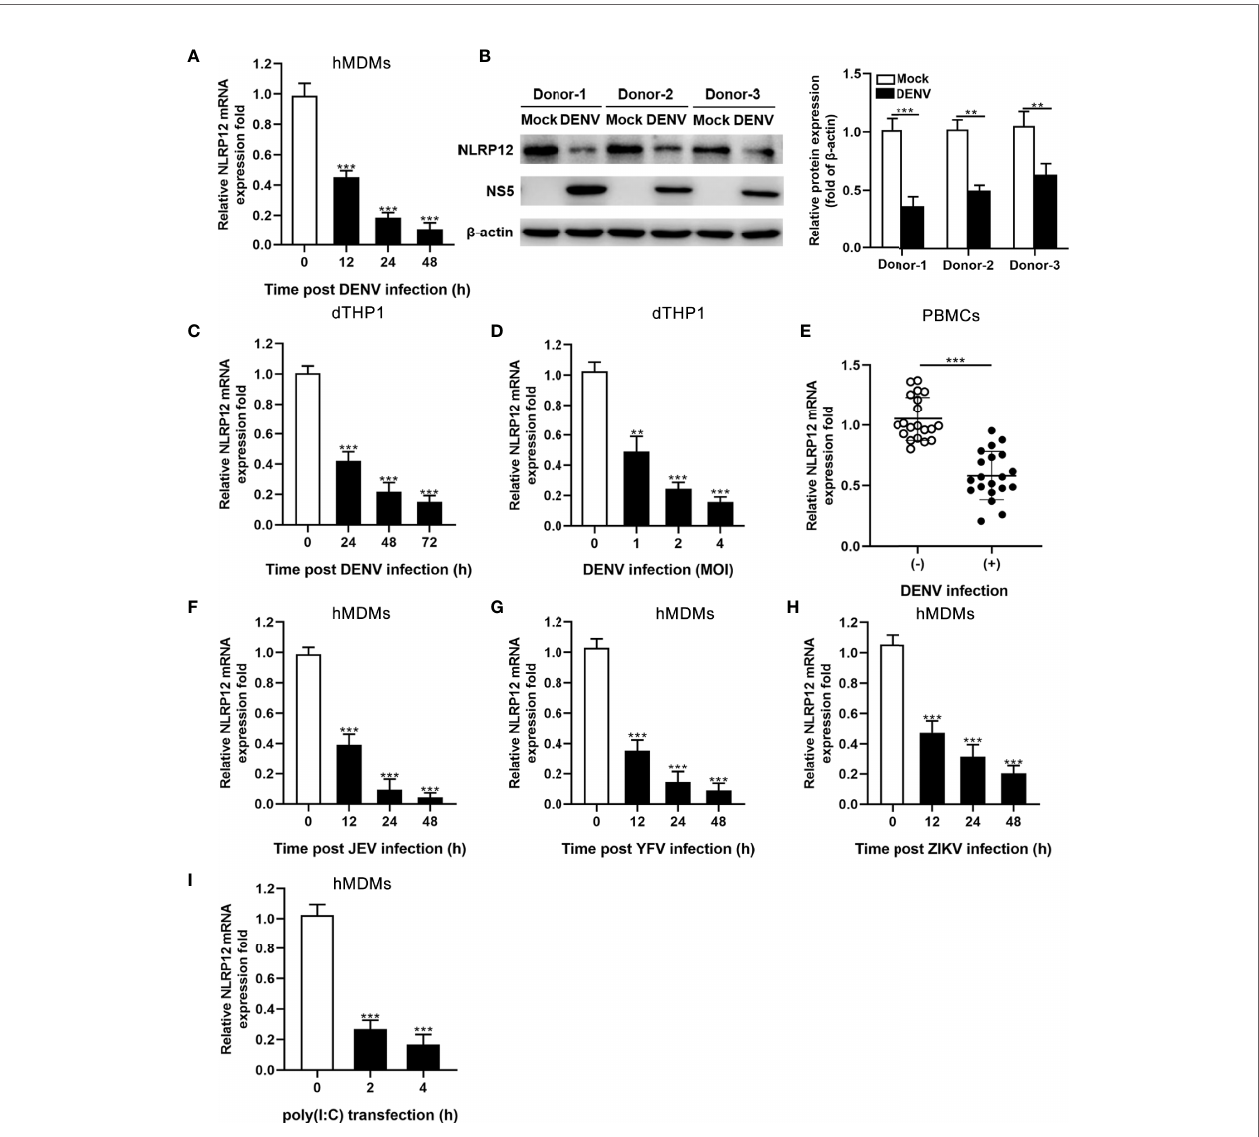
FIGURE 1 | DENV infection signi fi cantly down-regulated the expression of NLRP12. (A) Monocytes were isolated and induced into hMDMs using GM-CSF. Cells were infected with DENV (MOI=4) for indicated time points. The mRNA expressions of NLRP12 were detected by qPCR. (B) hMDMs from 3 different donors were infected with DENV for 48h (MOI=4), NLRP12 protein expression was determined via western blot analysis and the protein bands were quantitated by Image J gel image analysis software and the relative grayscale value was normalized to that of b -actin. (C, D) THP-1 cells were differentiated using PMA and infected with DENV for indicated time points (MOI=4) and indicated MOI (72h), the level of NLRP12 mRNA were evaluated by qPCR. (E) Total RNA of the PBMCs from patients with DENV infection and healthy donors was isolated, and qPCR was used to measure NLRP12 gene expression. (F – I) hMDMs were stimulated with JEV, YFV, ZIKV or poly (I:C) respectively for the indicated time (MOI=4), and qPCR was used to measure gene expression level of NLRP12. Each experiment was repeated a minimum of three times and the statistical signi fi cance was determined with analysis of one-way analysis of variance (ANOVA). **P < 0.01, ***P <